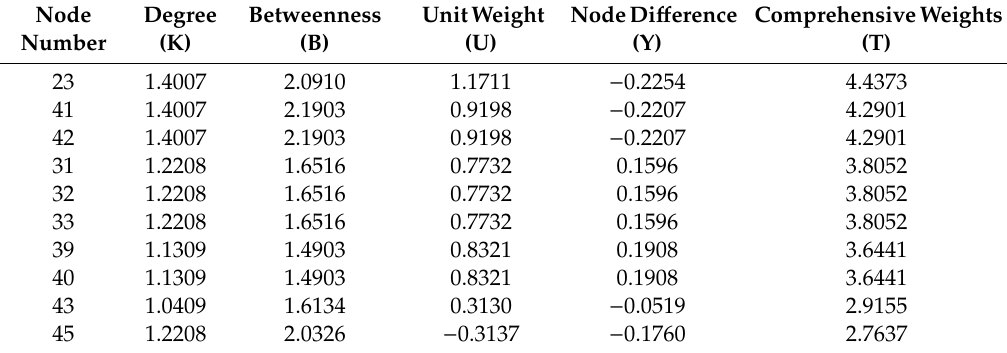
Table 6. Structural characteristics and comprehensive weights of the air transportation network.